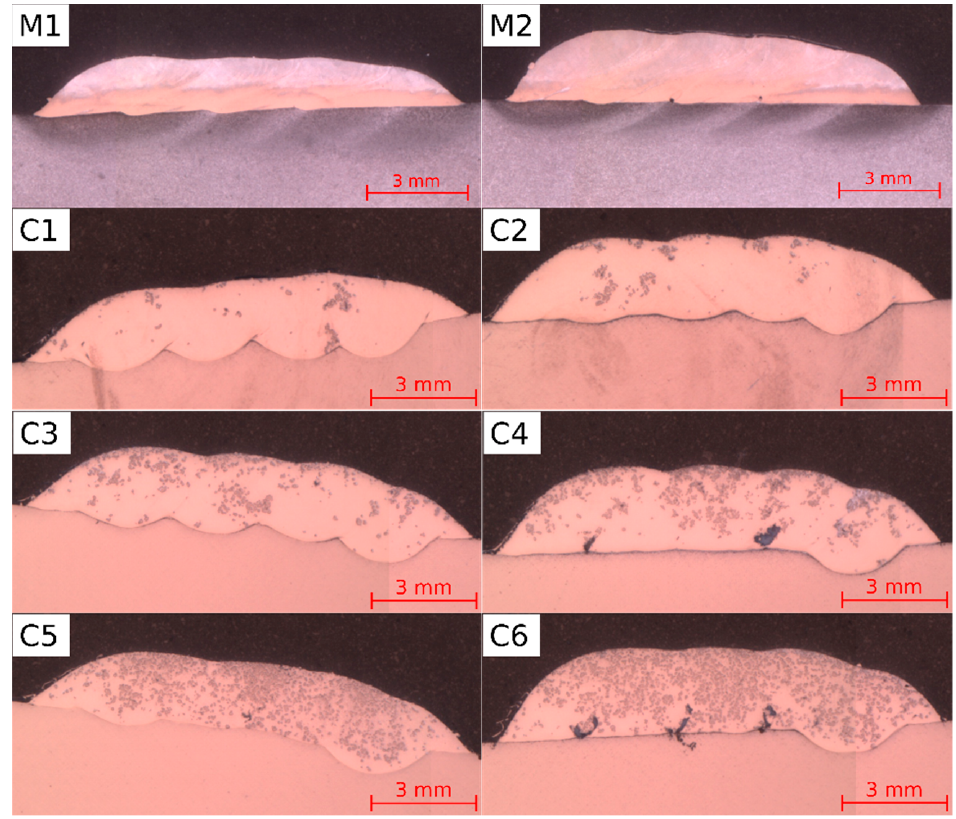
Figure 3. Macrographs of the laser-cladded coatings; designations in accordance with Table 3. Samples M1, M2 made without TiC, samples C1–C6 made with the addition of TiC. Table 4. Thickness, dilution and TiC volume fraction measurement results; designations in ac- cordance with Table 3.